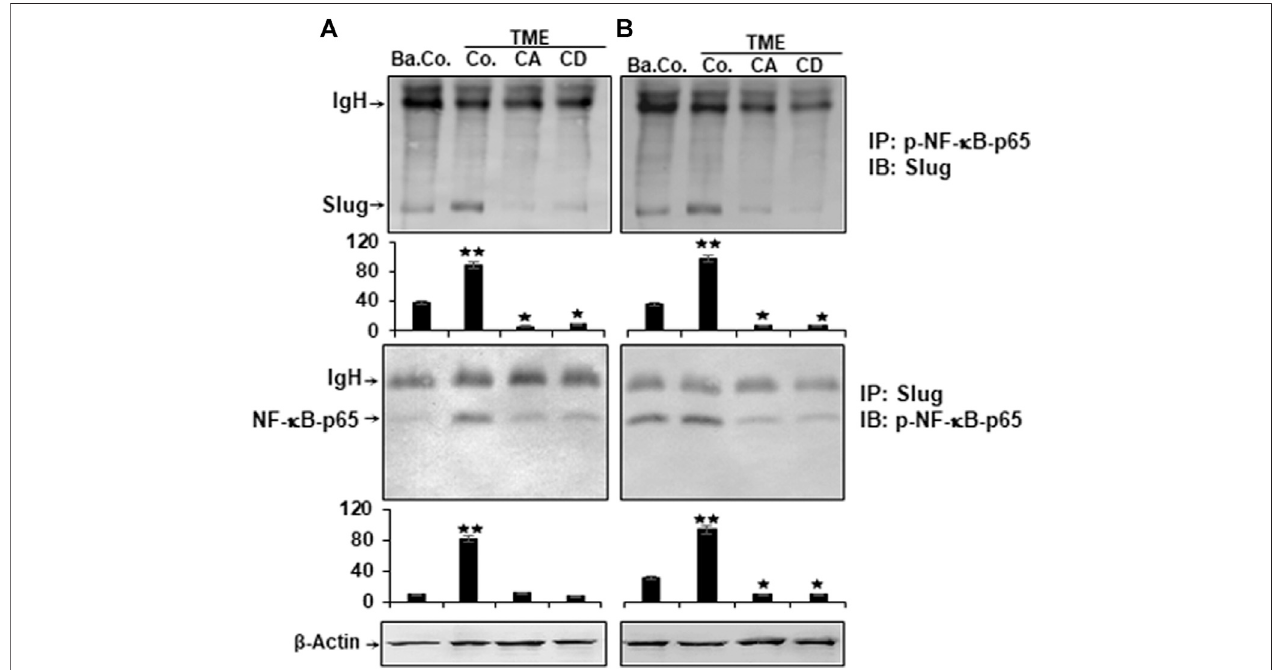
FIGURE8 | Calebin Aor cytochalasin D impact onTME-induced p-NF- κ B-p65 association with master EMT-related transcription factor (Slug) in colorectal cancer cells. HCT116 (A) andRKO (B) cellsinalginatematrixalone(B.Co.)orinTMEwerekeptwithouttreatment(Co.)ortreatedwithCalebinA(CA)orCytochalasinD(CD)as outlinedintheMaterialsandMethods.Thelysatesampleswereimmunoprecipitated(IP)usinganti-p-NF- κ B-p65orwithanti-Slug.Finally,eachimmunoprecipitateswas fractionated by SDS-PAGE and subjected to immunoblotting (IB) with anti-Slug or anti-p-NF- κ B-p65. Densitometric assays on protein levels as displayed with immunoblotting were carried out in triplicate. The initial samples were subjected to antibody against β -Actin as control. Values were comparable with the reference control. p < 0.05 (*), p < 0.01 (**). IgH (cid:2) immunoglobulin heavy chain.